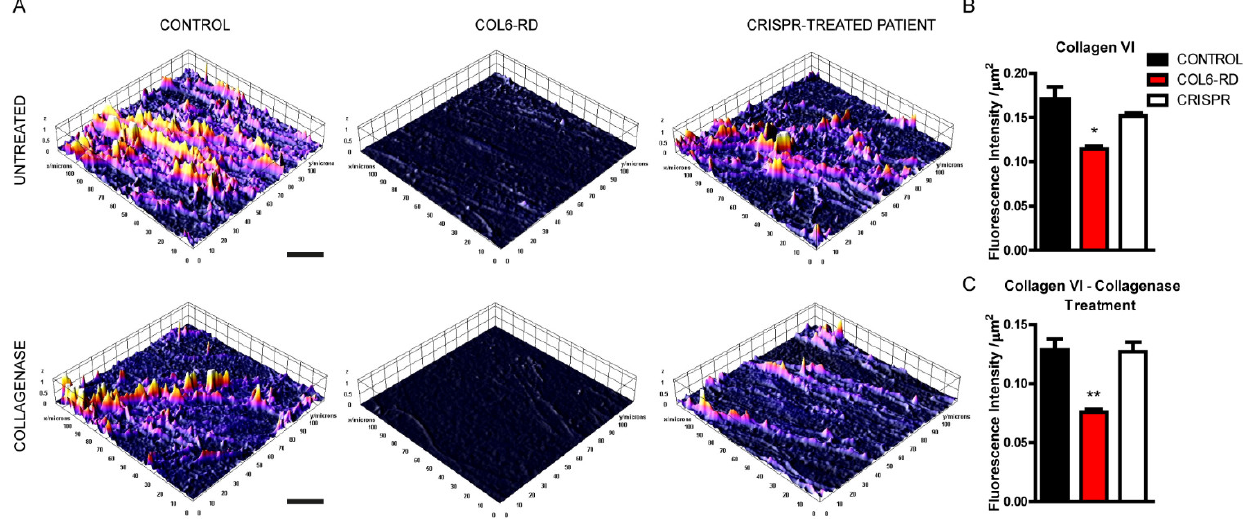
Figure 1 . Altered extracellular matrix in cultured COL6-RD patient-derived fibroblasts. ( A ) Repre- sentative 3D surface plot generated from the STED images (Figure S1) of the extracellular collagen VI matrix in untreated (upper panel) and collagenase-treated (lower panel) controls, patients, and CRISPR-treated fibroblasts showing the COL6 fluorescence levels. Fluorescence intensity analysis was also quantified in untreated ( B ) and collagenase-treated ( C ) samples. Data are expressed as the mean ± SEM; n = 3; independent primary cell preparations (30 images of 8–10 stacks for each CONTROL, COL6-RD, and CRISPR samples) were used for all panels. * p < 0.05, ** p < 0.01; one-way ANOVA/Bonferroni’s multiple comparison test. Scale bar 5 µm.